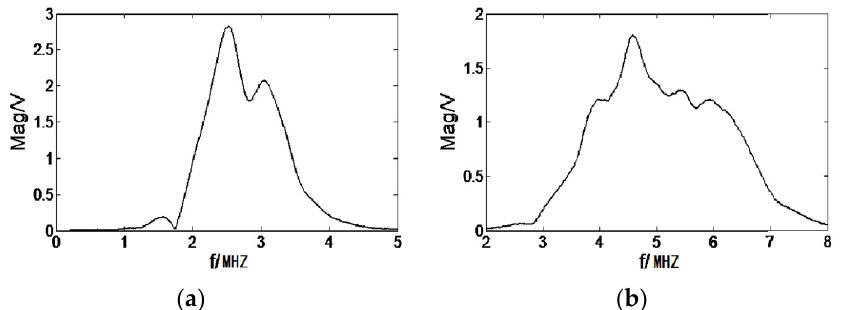
Figure 5. frequency response ( a ) 2.25 MHz transducer, ( b ) 5 MHz transducer. Figure 5. Frequency response ( a ) 2.25 MHz transducer, ( b ) 5 MHz transducer.